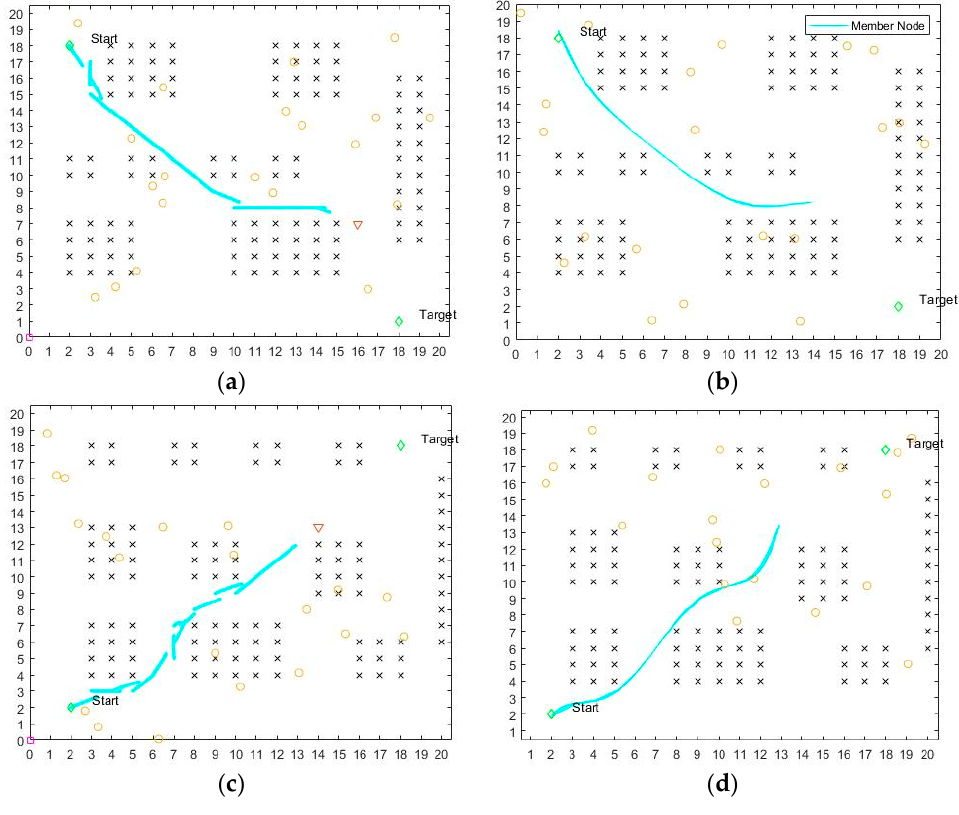
Figure 13. Addition of dynamic obstacles.